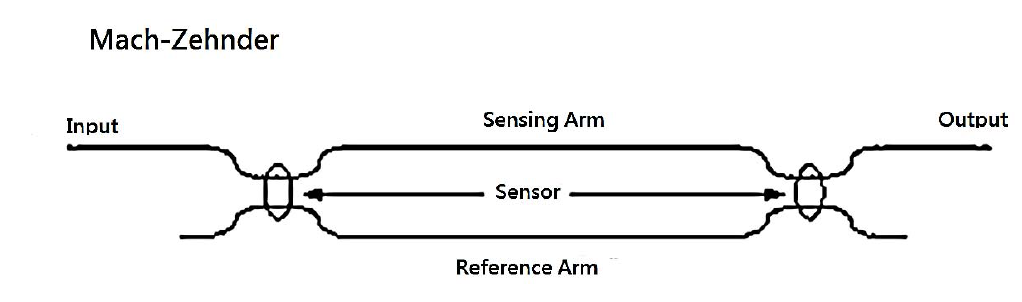
Figure 1. Mach-Zehnder interferometer.